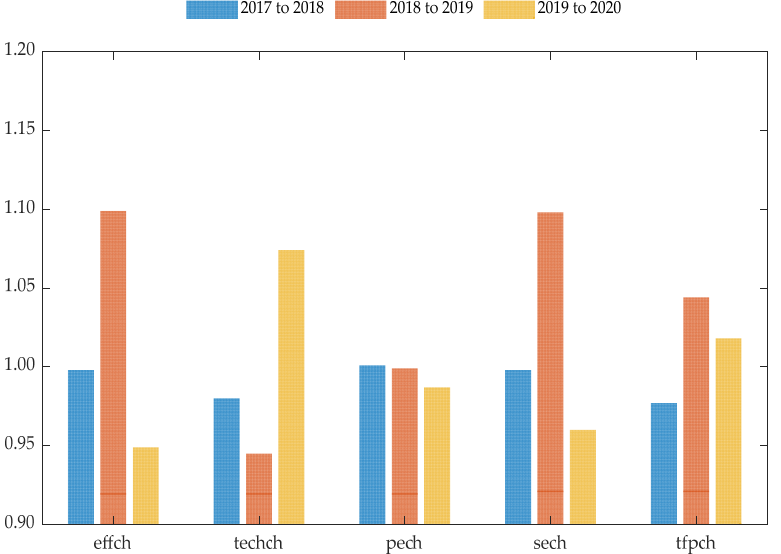
Figure 3. Change trend of average efficiency of the three ‐ stage period. From a global perspective, according to the results of the Malmquist index model, the increase in total factor productivity of SCC in the 11 pilots mainly depends on the scale efficiency change index, which is limited by the technological progress index and the pure technical efficiency change index. From 2017 to 2018, only three of the selected pilots were in the growth state, with a total factor productivity index greater than 1 (accounting for only 27.27%); from 2018 to 2019, the proportion of the pilots in the growth state of the total factor productivity index was 45.46%; from 2019 to 2020, the pilots with a total factor productivity index in the growth state accounted for 54.55%; from 2017 to 2020, the average value of the total factor productivity index of all selected pilot cities was 1.013, which is